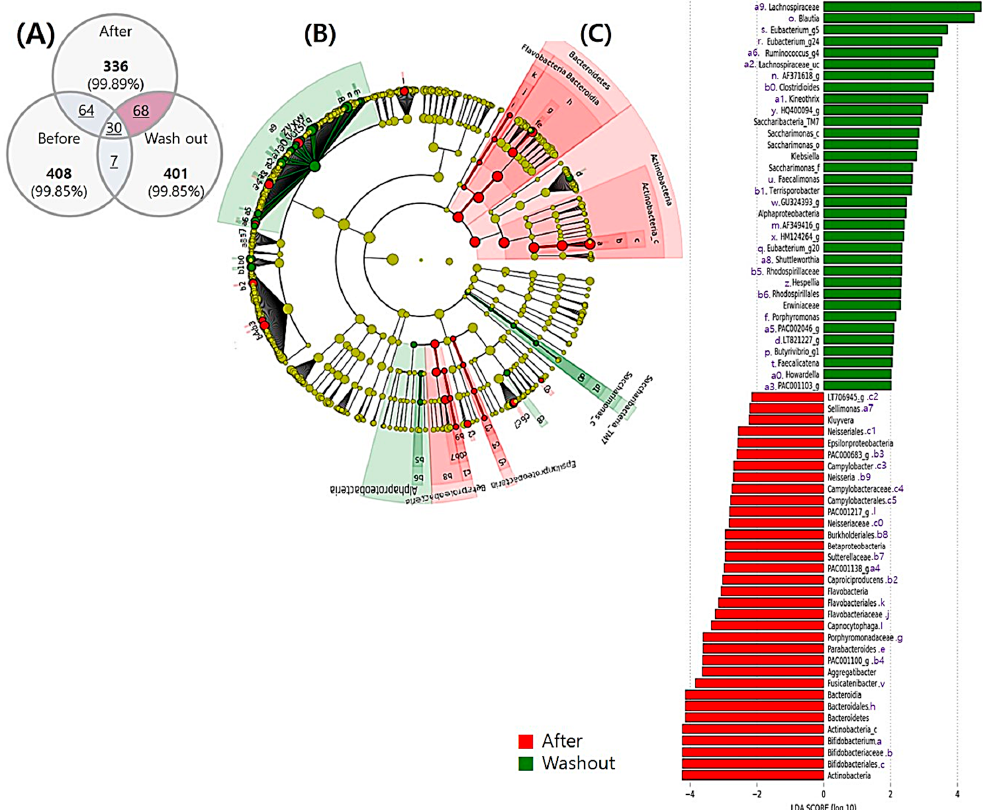
Figure 4. Cross-taxa profile of intestinal microflora in all subjects ( n = 37) after synbiotic ingestion and during washout. ( A ) Venn diagram for the distribution of operational taxonomic units (OTUs) at each time point. ( B ) Cladogram showing phylogenetic relationships between taxa with significant di ff erences between time points. ( C ) Linear discriminant analysis e ff ect size (LEfSe) showing the contribution of di ff erent bacteria to the di ff erences between the after ingestion and washout periods. Green color indicates taxa enriched after ingestion, and red color indicates taxa enriched in the washout period.